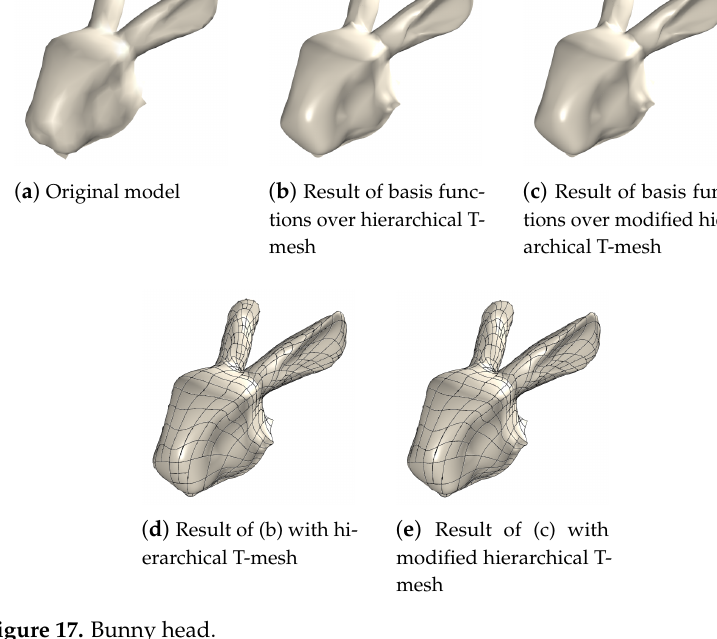
Figure 17. Bunny head.